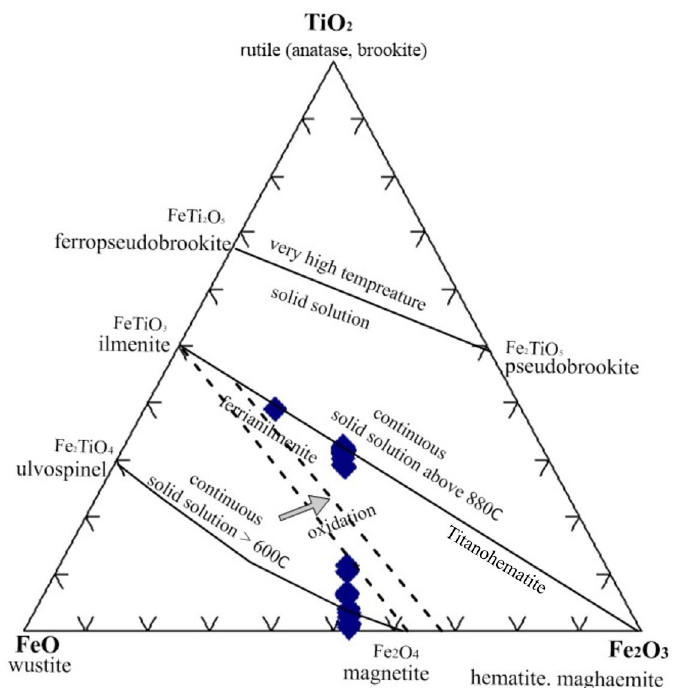
Figure 13. TiO 2 -FeO-Fe 2 O 3 solid system diagram showing the composition and approximate equi- librium lines (dashed lines) between analyzed titano-magnetites from gabbro of Abu Ghalaga area [36,37].